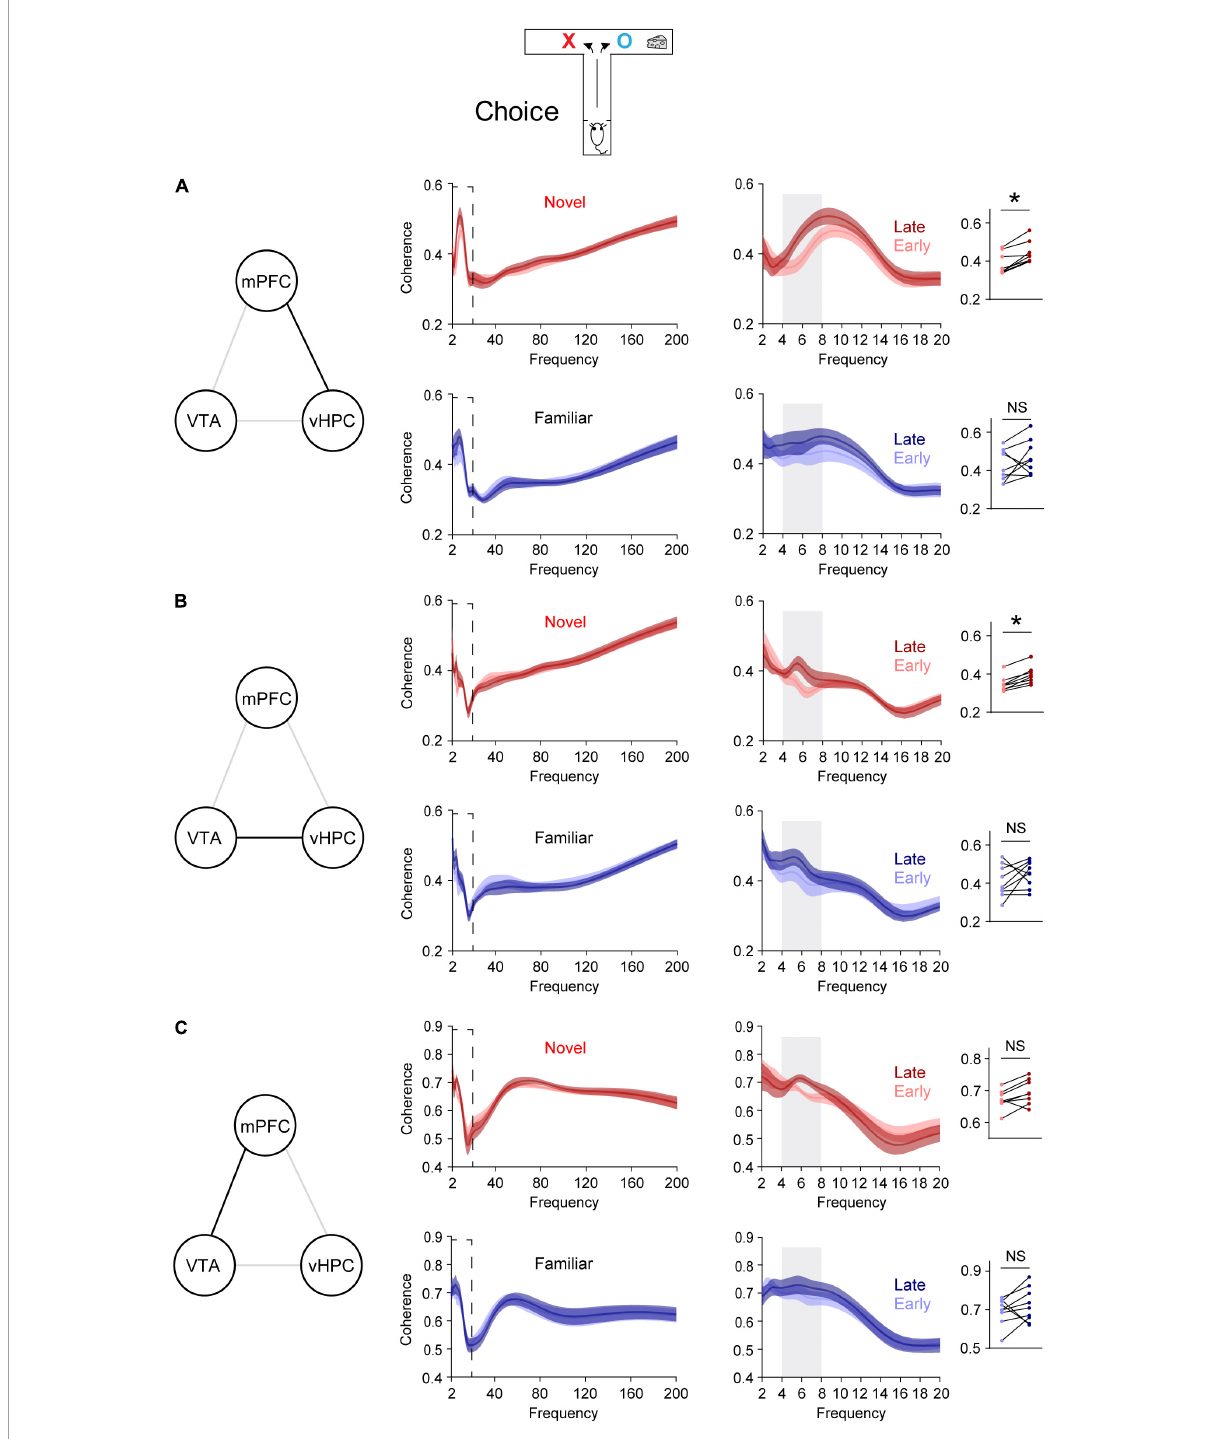
FIGURE2 Novelty selectively permits learning-dependent theta coherence increase in the VTA-vHPC-mPFC circuit when mice flexibly choose a goal side. Coherence in the dashed box on the left is shown on the right. Dot plots show the average theta coherence of each mouse. (A) Mice exposed to the novel, but not the familiar, area displayed increased vHPC-mPFC theta coherence in late training compared with that of early training (Novel, P = 0.008; Familiar, P = 0.4). (B) The novel, but not the familiar, group showed increased VTA-vHPC theta coherence in late training compared with that of early training (Novel, P = 0.008; Familiar, P = 0.3). (C) Both novel and familiar groups exhibited similar mPFC-VTA theta coherence between the early and late choice phase of flexible choice training (H: Novel, P = 0.05; I: Familiar, P = 0.4). Wilcoxon signed-rank test. NS. not significant, novel ( n = 8), familiar ( n = 9), * P < 0.05. Data are represented as mean ±